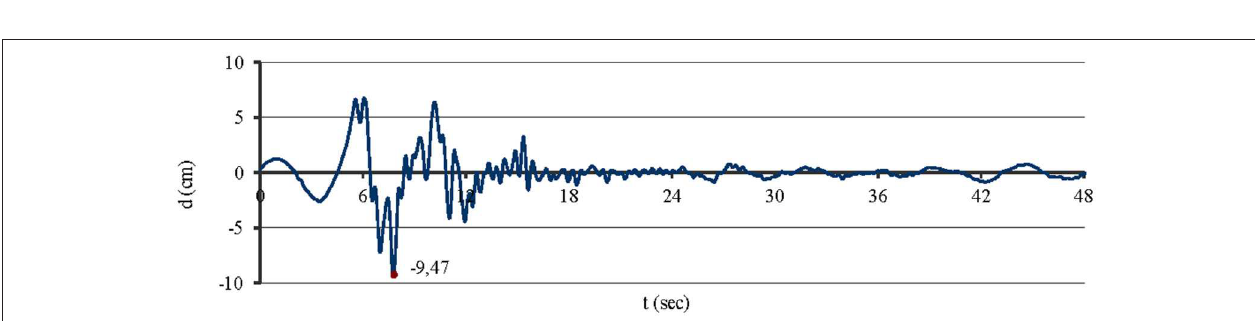
Frontiers in Built Environment |